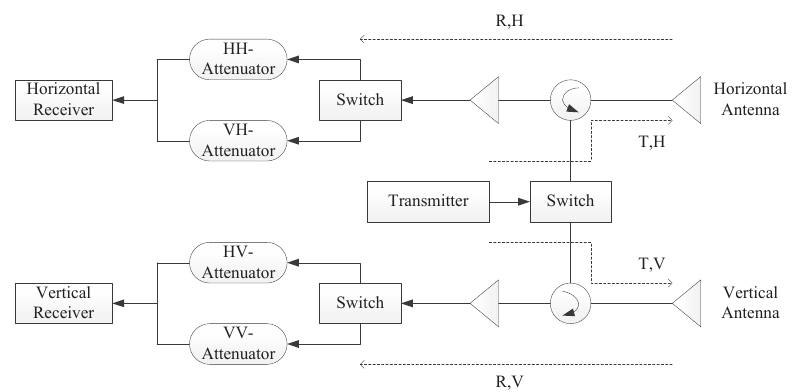
Figure 3. System model architecture for